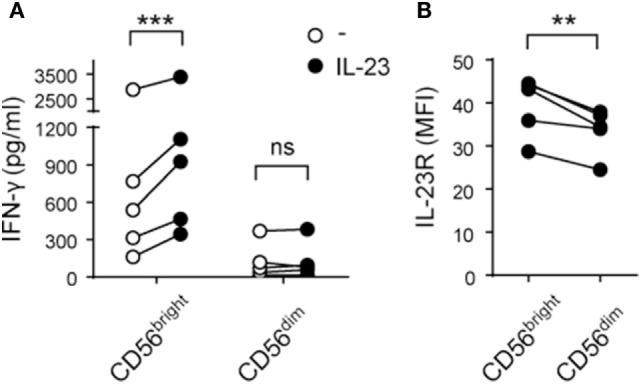
CD56bright natural killer (NK) cells secrete IFN-γ in response to interleukin (IL)-23 and express higher amounts of IL-23R than CD56dim NK cells. (A) IFN-γ secretion by FACS-sorted CD56bright and CD56dim NK cells cultured for 24 h in the absence (○) or in the presence (●) of IL-23; n = 5. (B) IL-23 receptor (IL-23R) expression on CD56bright and CD56dim NK cells; n = 5. ns, not significant; **p < 0.01; ***p < 0.001; two-way ANOVA with Bonferroni’s post hoc test (A) and paired t-test (B).